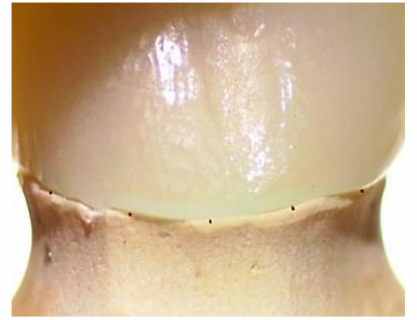
Figure 11. Equidistant points of measurements on